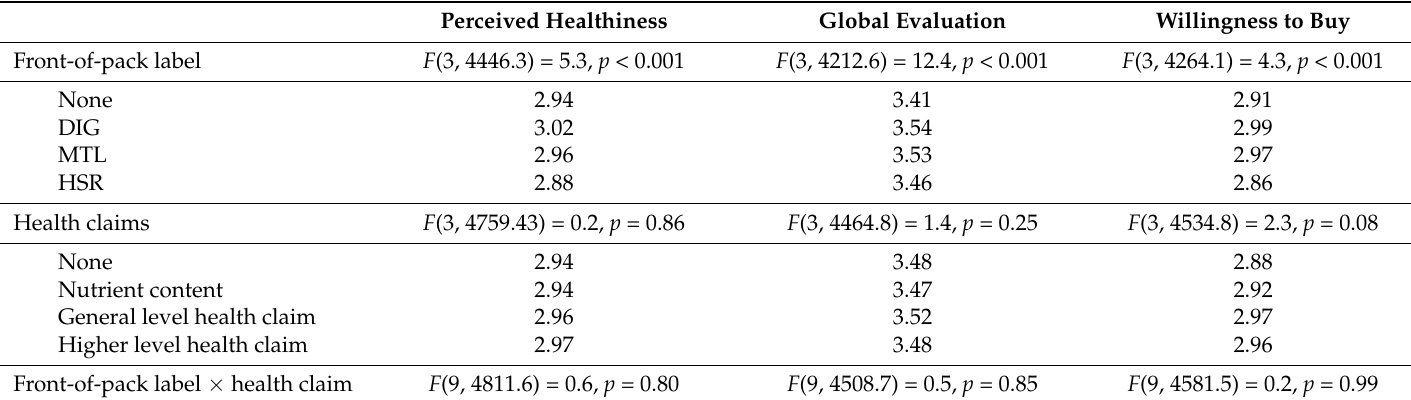
Table 2. Means, main effects and interaction effects for front-of-pack labels and health claims (with age, gender and Socio-Economic Status as covariates) on perceived healthiness, global evaluations and willingness to buy across all foods ( n =